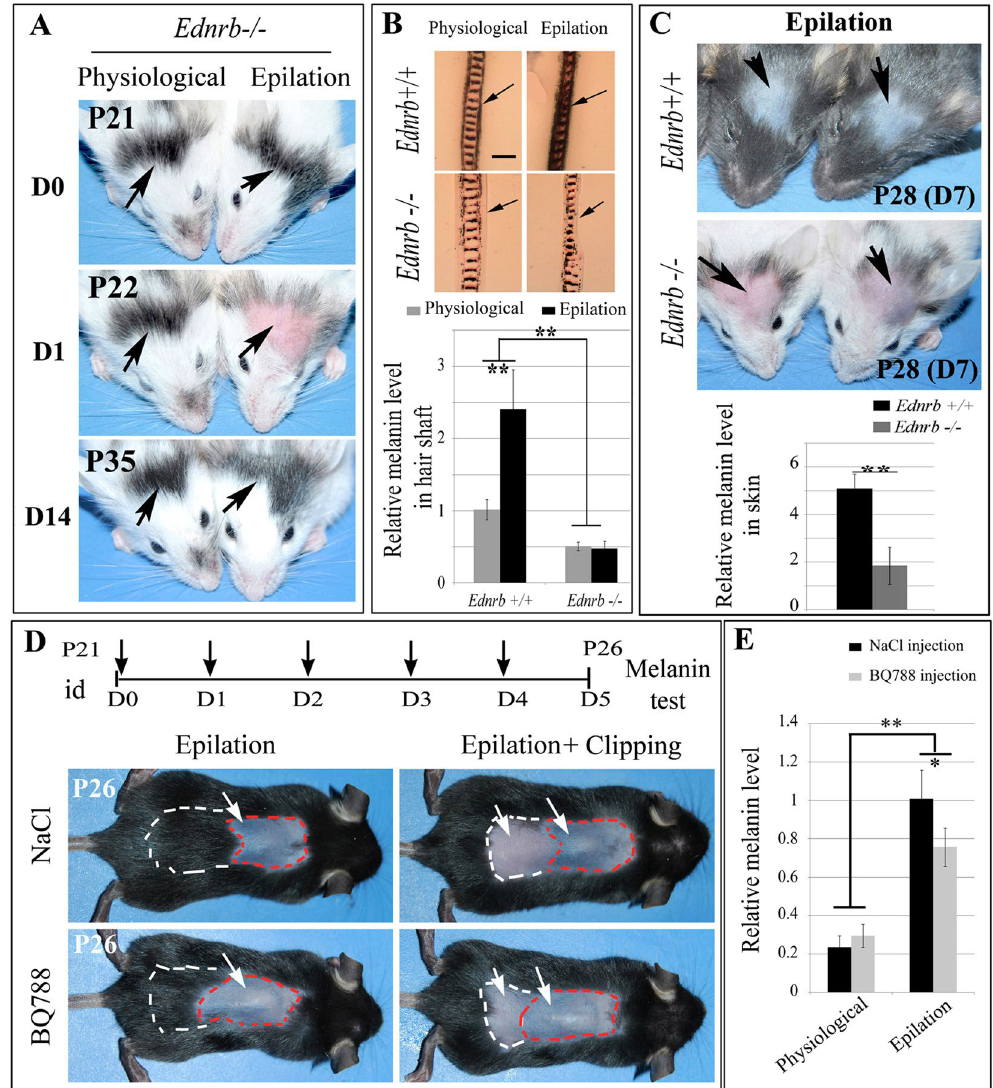
Figure 4. Genetic and pharmacological disruption of Ednrb blocks epilation-induced hair and skin hyperpigmentation. ( A ) Hair pigmentation of Ednrb − / − mice before and after epilation at P21. Arrows point to the epilated (right panels) and unepilated (left panels) pigmented hairs of Ednrb − / − scalp. ( B ) Histological section of hairs (upper panels) and melanin content (lower panel) of the hair shafts of wildtype and Ednrb − / − mice before and after epilation. Arrows indicate the decrease of melanin in the hair shaft of Ednrb − / − mice. ( C ) Pigmentation of P28 scalp of wildtype and Ednrb − / − mice after epilation at P21. Arrows point to the epilated area of wildtype (upper panels) and Ednrb − / − mice (lower panels). ( D , E ) Back skin of P26 mice epilated at P21 and intracutaneously injected with either physiological saline (upper panels) or BQ788 (lower panels) on the days indicated by the vertical arrows ( D ). The white arrows point to the skin color of epilated and clipped areas. ( E ) The graph shows relative melanin levels of the back skin. Note that on day 5 after epilation along the red dotted line, clipping along the white dotted line shows the surrounding hairs as controls for physiological regeneration of hair follicular pigmentation. id, intradermal injection. * indicates p < 0.05; ** indicates p <